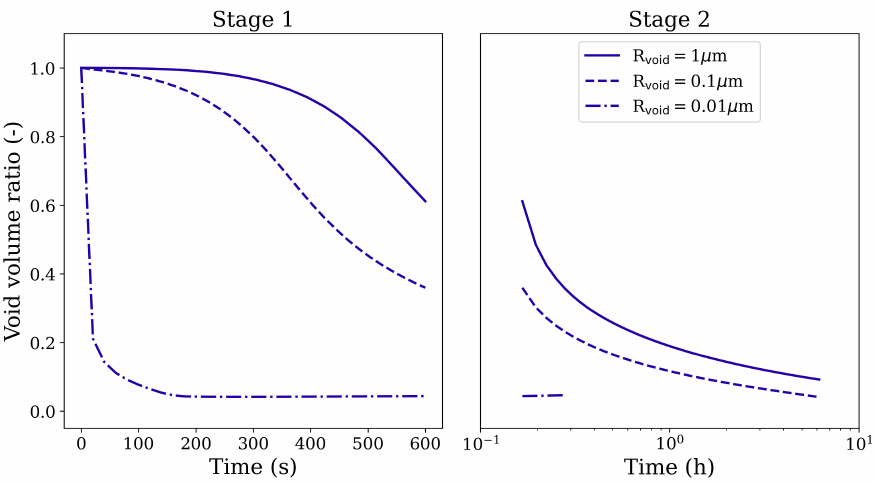
Figure 14. Void volume reduction ratio in Stage 1 and Stage 2 HIP loading for spherical voids of various radii under 100 MPa isostatic pressure at 1561